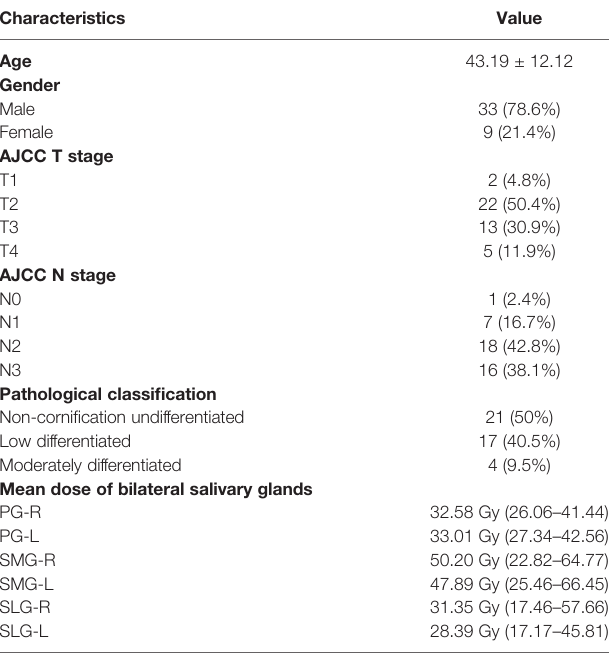
TABLE 1 | Demographic and clinical characteristics of patients.